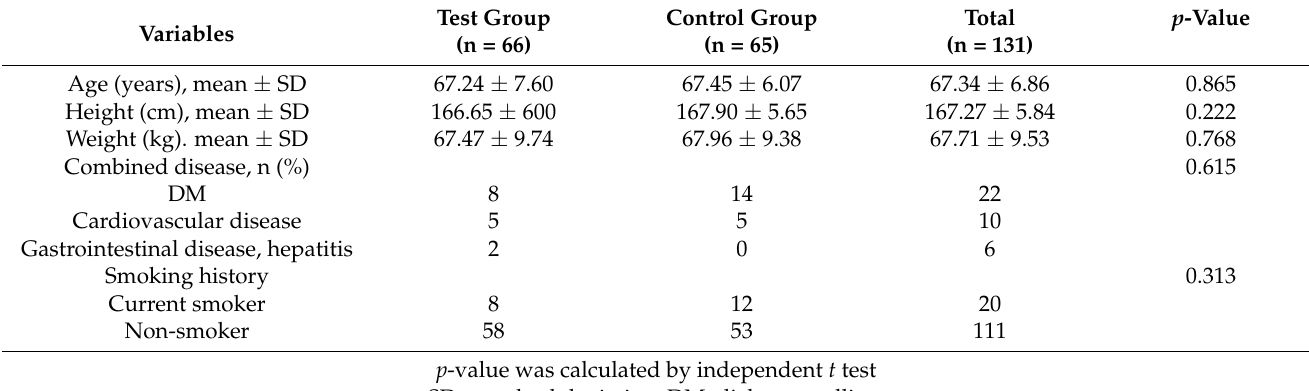
Table 1. Demographic data of collagen type-I agent group (Test group) and hyaluronic acid car- boxymethylcellulose (HA/CMC) group (Control group).